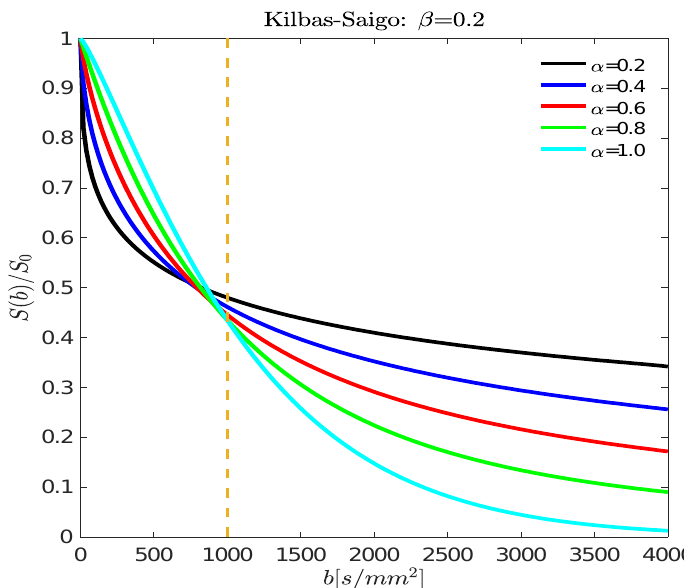
Figure 6. The normalized stretched Kilbas-Saigo signal decay of S(b)/S 0 is plotted versus b -values between 0 and 4000 s/mm 2 , and D 0 = 1 × 10 − 3 mm 2 /s with α = 0.8, and β = 0.2, 0, − 0.2, − 0.4, and − 0.6. In this figure, we observe the effects of both α and β on the decay.